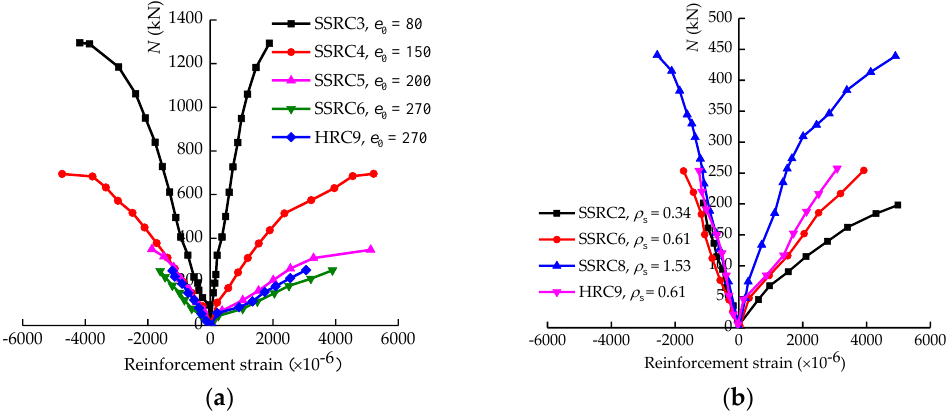
Figure 7. Load – longitudinal reinforcement strain curves under various ( a ) eccentricities and ( b ) reinforcement